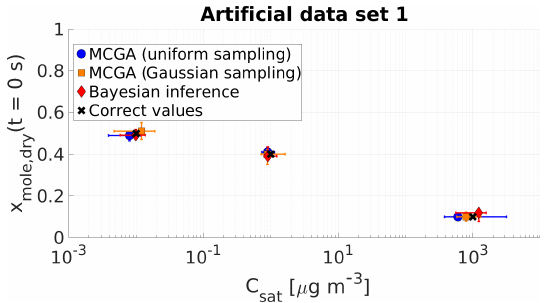
Figure 2. Parameter estimates from the three different optimiza- tion methods applied to artificial data set 1. Shown are MCGA with uniform sampling (blue circles), MCGA with sampling distri- butions similar to the Bayesian inference (Gaussian sampling, yel- low squares) and Bayesian inference (red diamonds). The markers show the modes of the estimated variable distributions for MCGA methods and the maximum a posteriori estimate of the fitting vari- able distributions for the Bayesian inference. The whiskers show the 10th and 90th percentiles of the variable distributions for the MCGA methods and 90% credible interval for the Bayesian